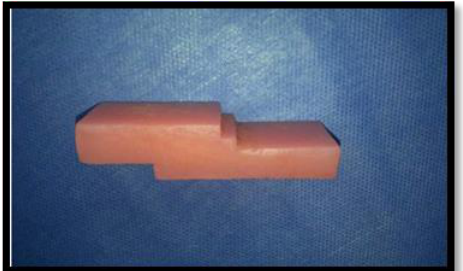
Figure 3: An acrylic block of the shear bond strength